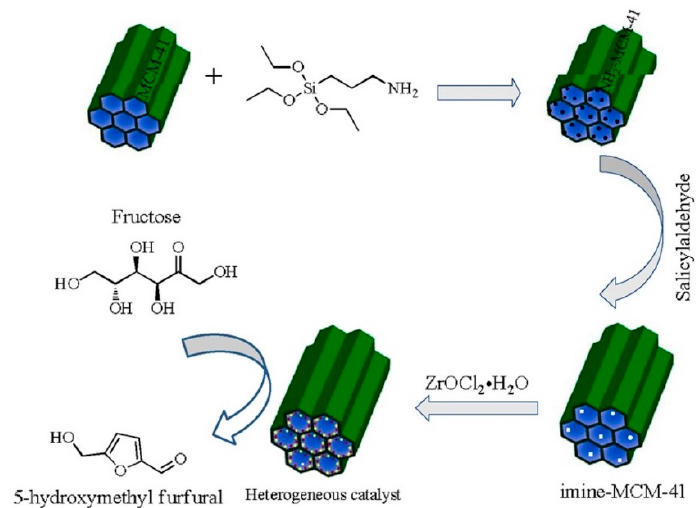
Figure 34. Zr(IV)-salen-MCM-41 synthesis to catalyze fructose. Reproduced with permission from [47]. Copyright 2018 Elsevier B.V.